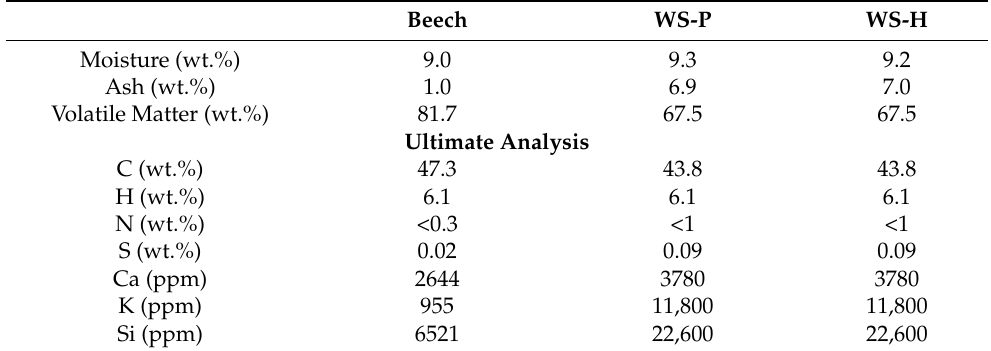
Table 4. Proximate, ultimate, and elemental analysis of the feedstocks used in the work. All values in dry base. Beech WS-P WS-H Moisture